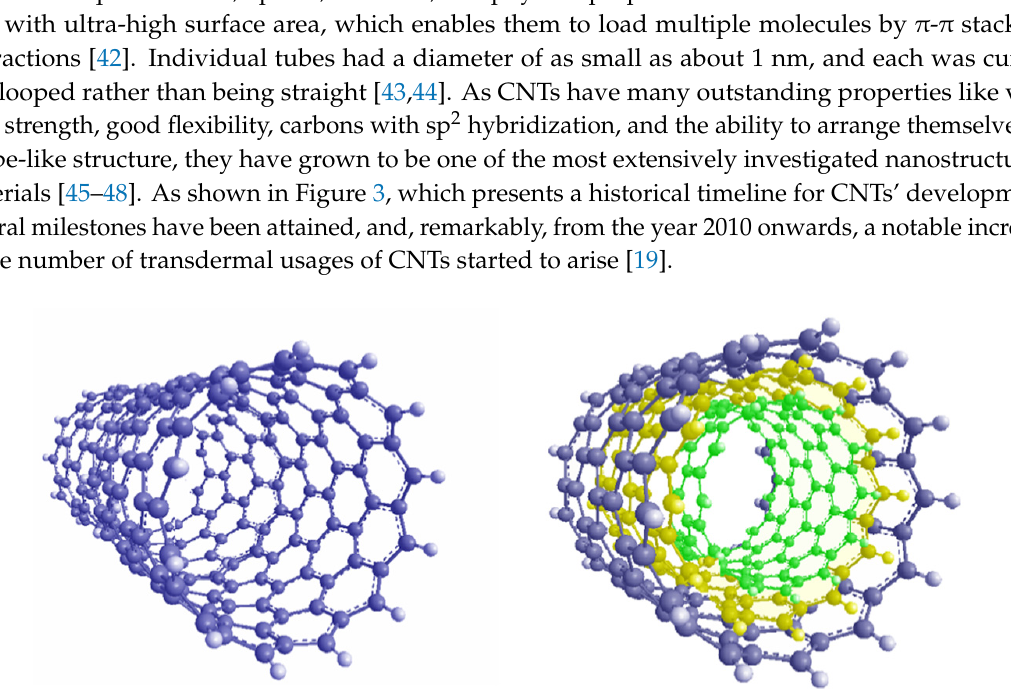
Figure 3. A brief historical timeline for CNTs showing the major developments that guided applications of CNTs [19]. CNTs as one type of one-dimensional nanomaterials have a large specific surface area in the range of 50 to 1315 m 2 /g. The CNTs’ radial dimensions are nano-sized, but the axial dimensions are